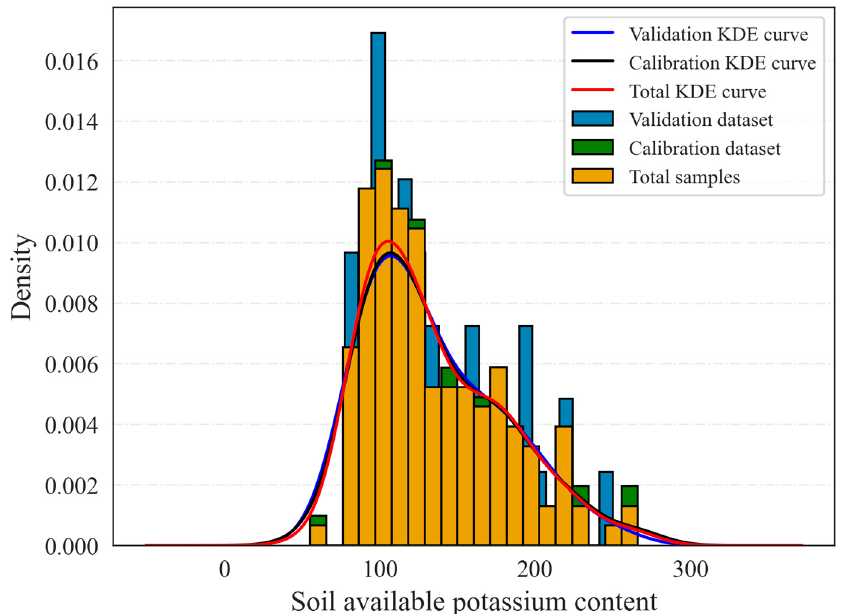
Figure 2. Data distribution of total samples, validation dataset and calibration dataset. Total, validation and calibration KDE curve means kernel density estimation curve of total, validation and calibration dataset, respectively.